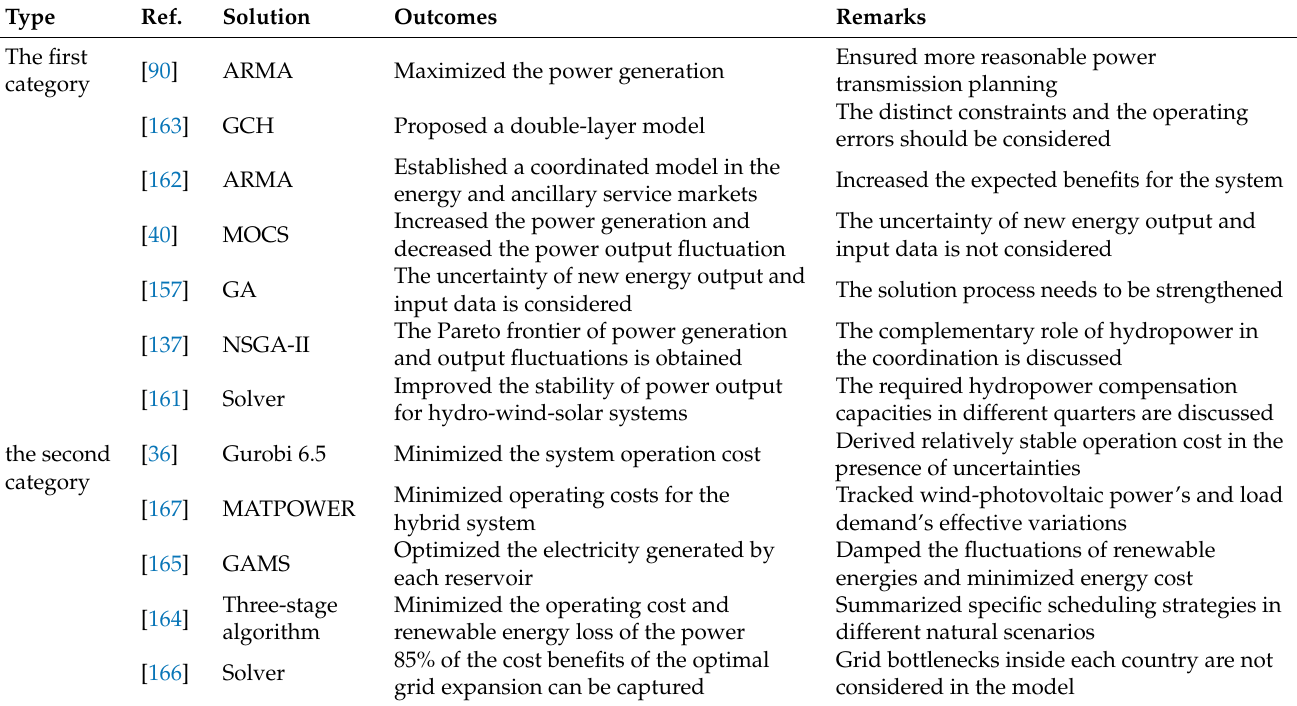
Table 4. Summary of reviewed articles to show the status of short-term